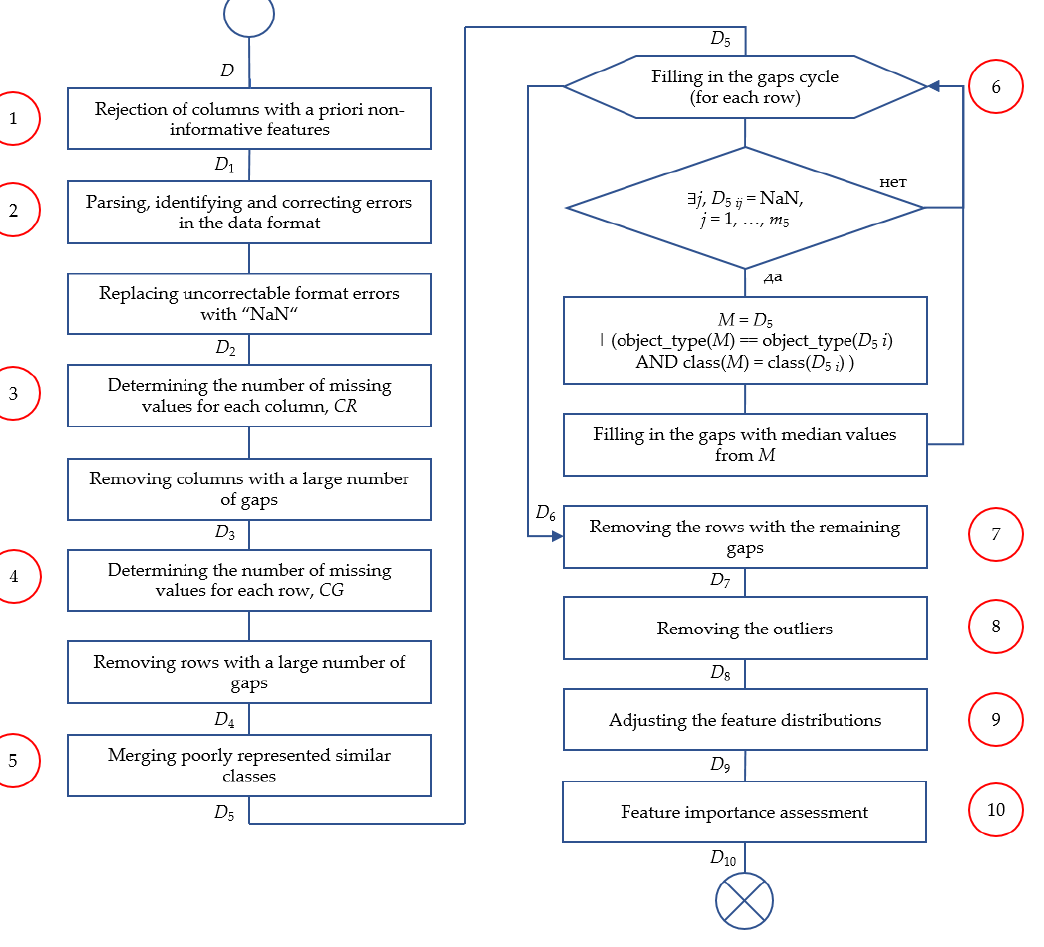
Figure 1. Block diagram of the data preprocessing algorithm.